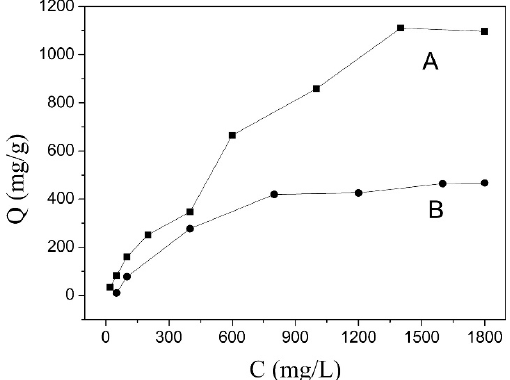
Figure 7. Adsorption isotherms of methyl orange (MO) on the precursor ( A ) and LDH ( B ). Reproduced with permission from [42]. Copyright Elsevier, 2016.